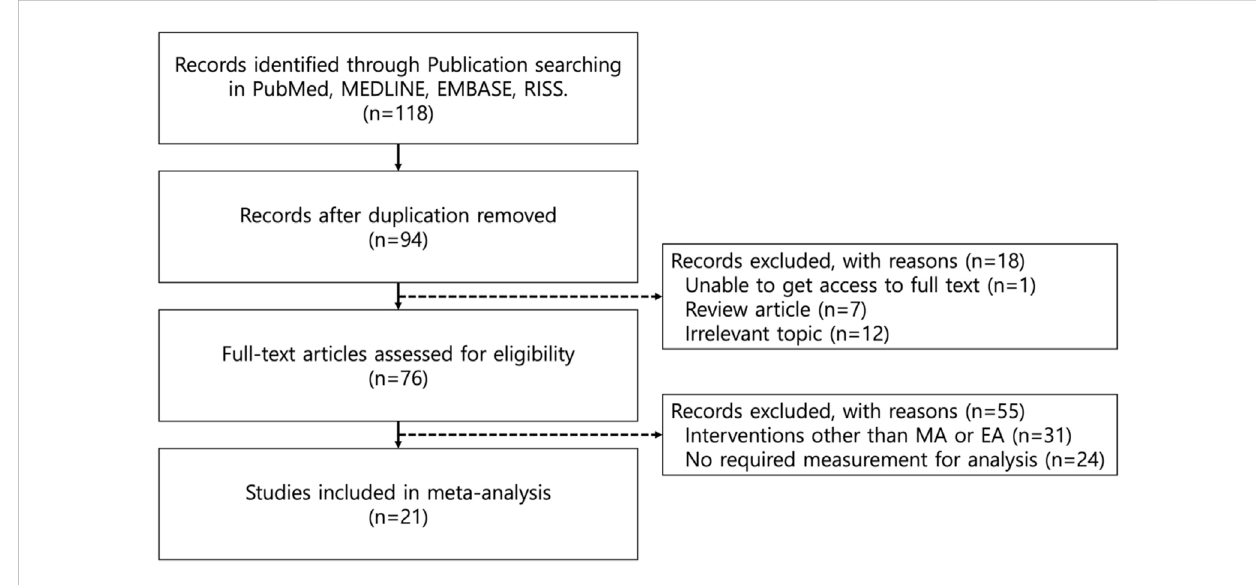
FIGURE 1 Flow diagram for Inclusion and Exclusion